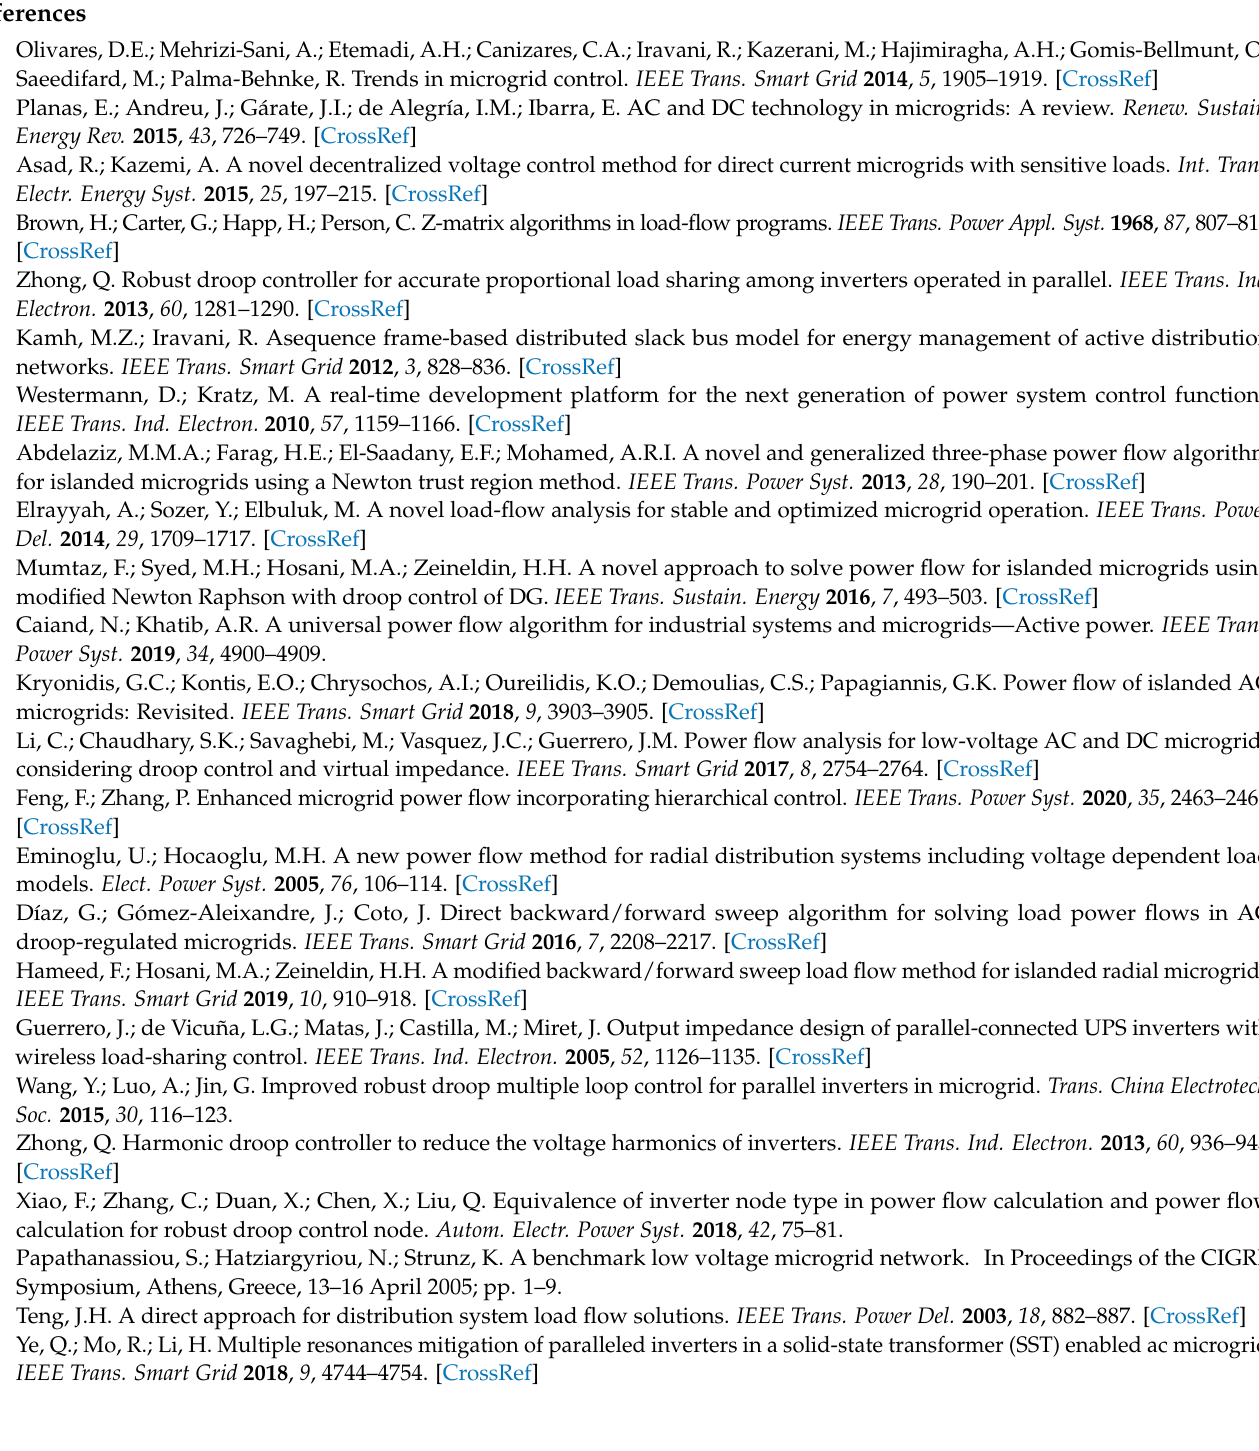
Tables A1 and A2 show that the reactance of the filter is much larger than the impedance of the transmission line; therefore, the reactance of the filter should be consid- ered in the power flow